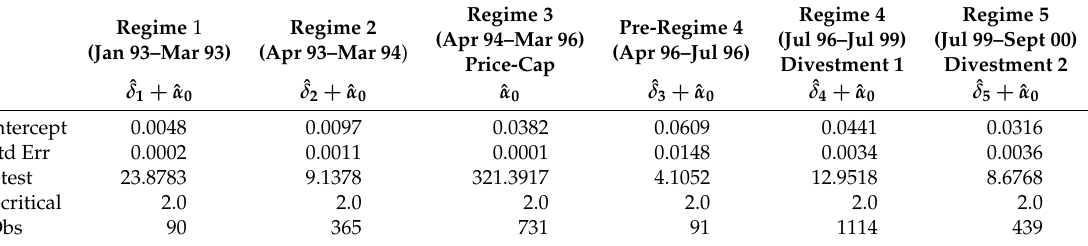
Table 10. Volatility across different